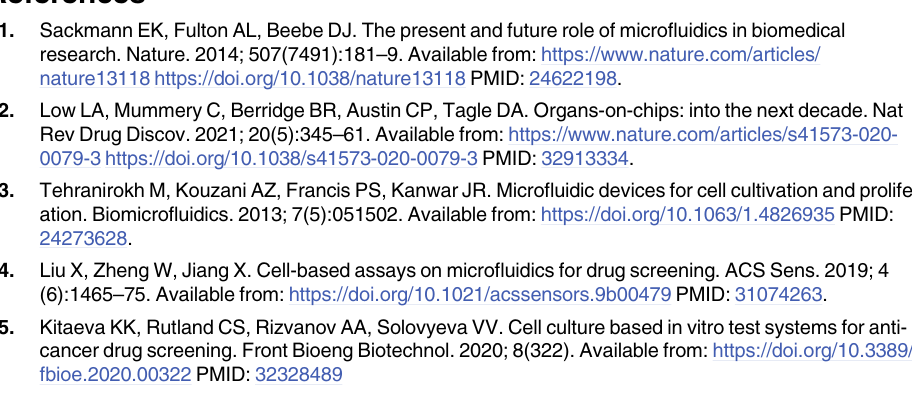
S1 Fig. Simulation of hydrodynamic flow focusing and shifting in different HFSM designs. S2 Fig. Simulation of the time-dependent concentration changes of a hydrodynamically shifted sample flow. S3 Fig. Reduction of cell area on the stream path of trypsin EDTA